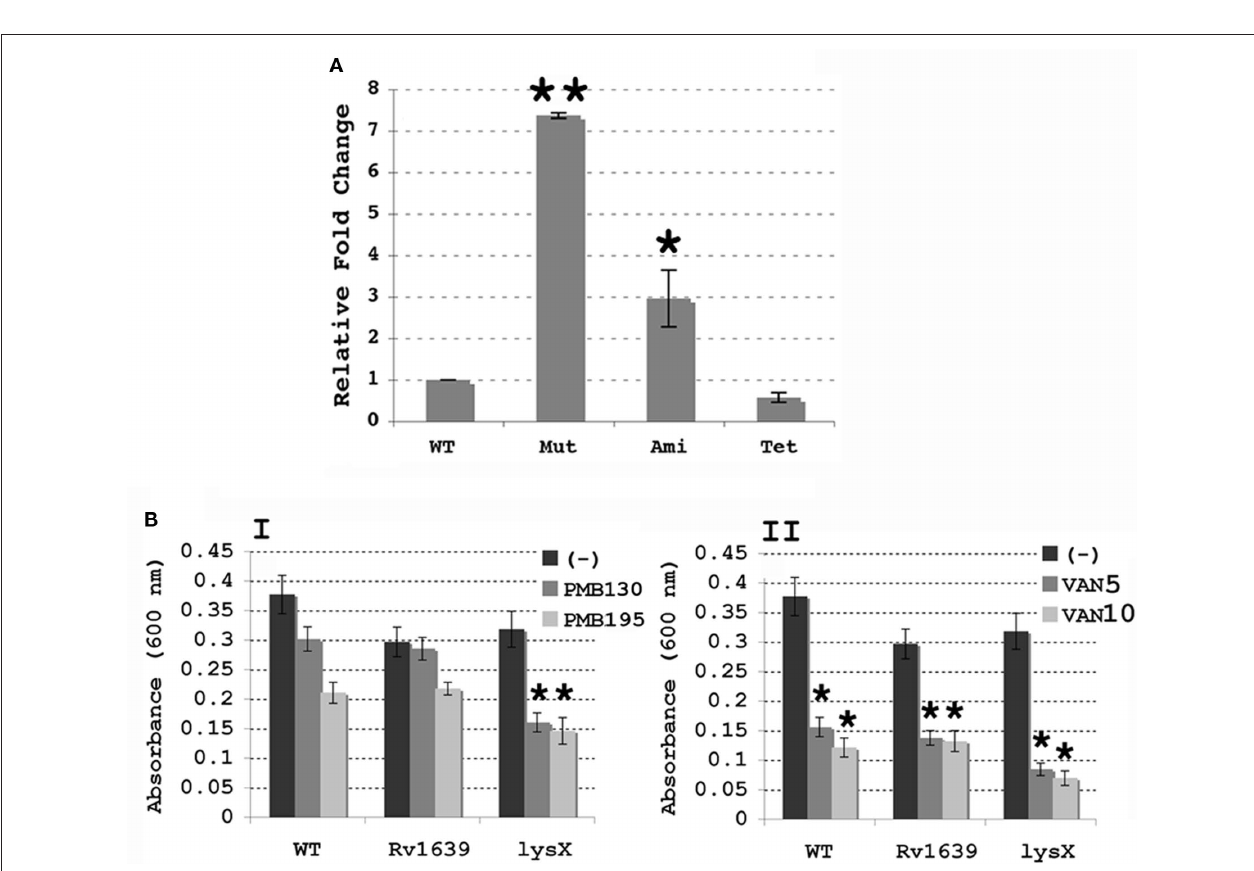
t -test). (B) Antibiotic sensitivity of M. smegmatis merodiploid strains overproducing Rv1639 and Lys X proteins. Cultures were grown in the presence or absence of either (A) Polymyxin B 130 and 195 U/mL, or (B) vancomycin 5 μg/mL, 10 μg/mL (VAN5, VAN10). Bars represent absorbance values for each culture. The values represented are the means ± SD for four independent samples; stars represent P < 0.01 compared with the control culture (-) for each (Student’s t